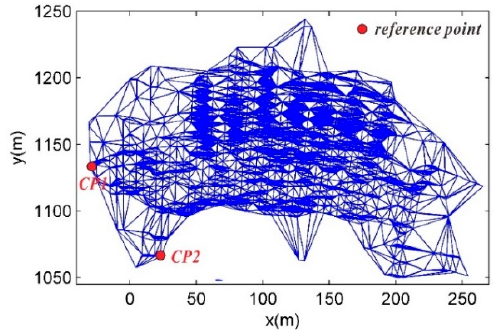
Figure 9. Irregular triangular network constructed using CPTs.